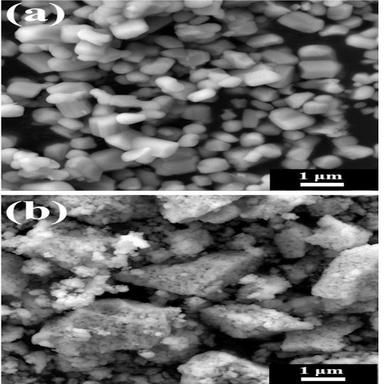
SEM images of TiNb2O7 powders synthesized via (a) the solid state method and (b) the agar-assisted method.